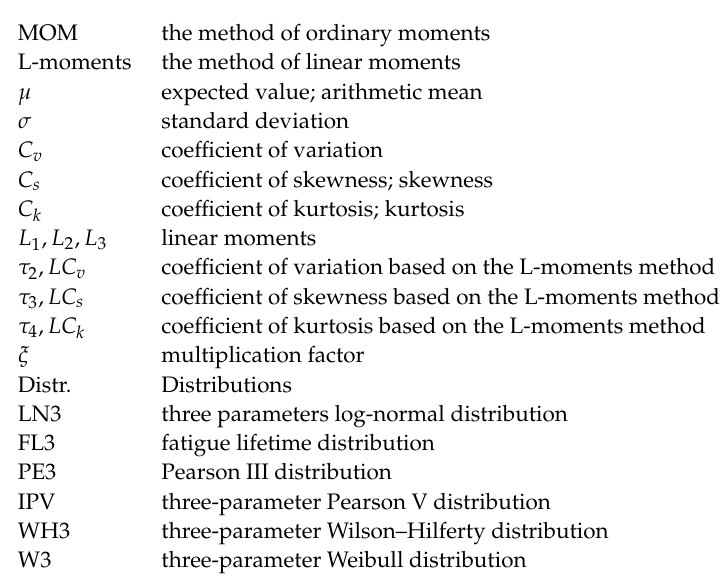
for minimum 1-day low flows, Table S1: The observed data from Prigor hydrometric station, Table S2: The statistical indicators of the observed values, Table S3: The annual volumes deficit, Table S4: